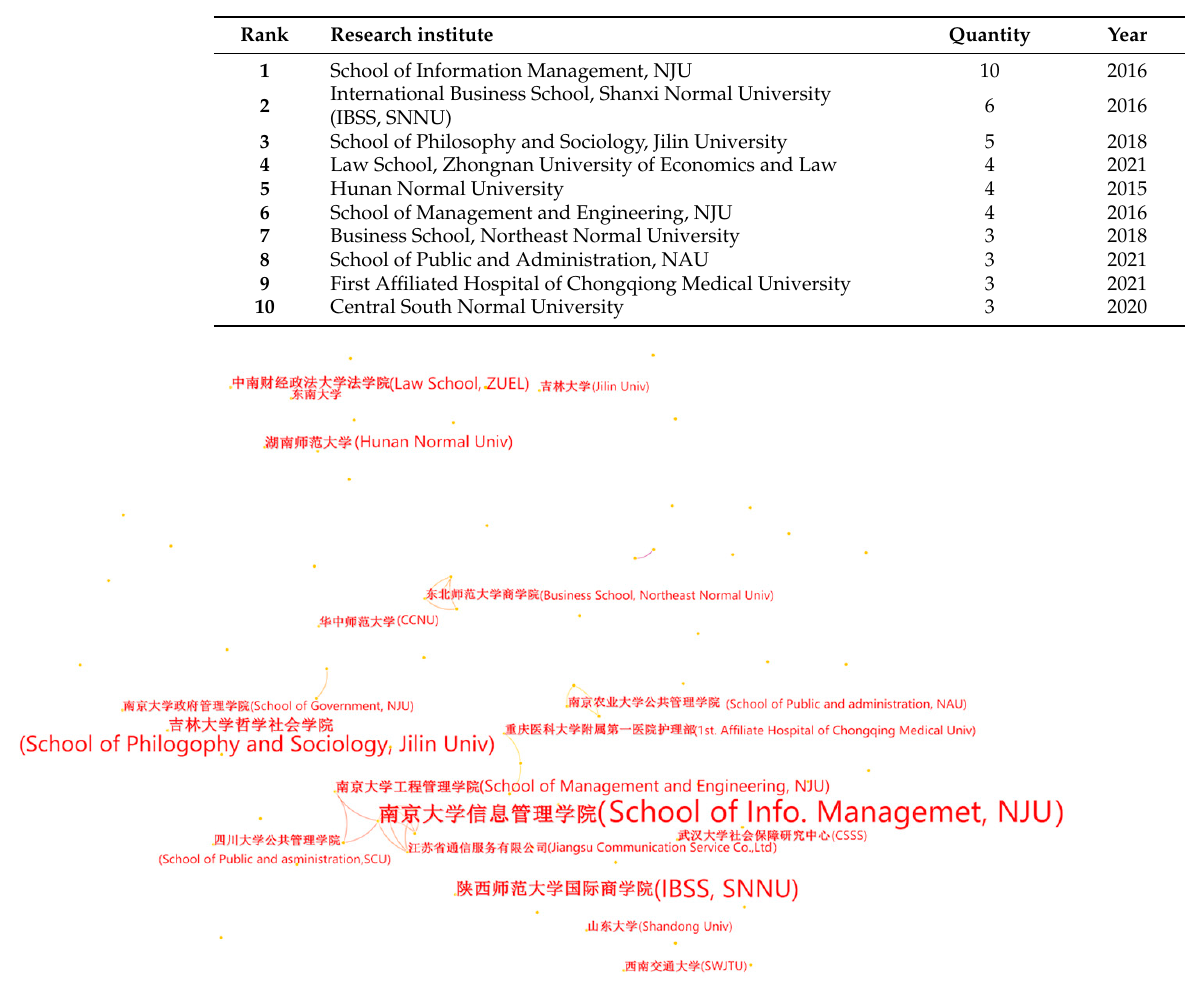
Table 6. The institution networks of studies from CNKI.